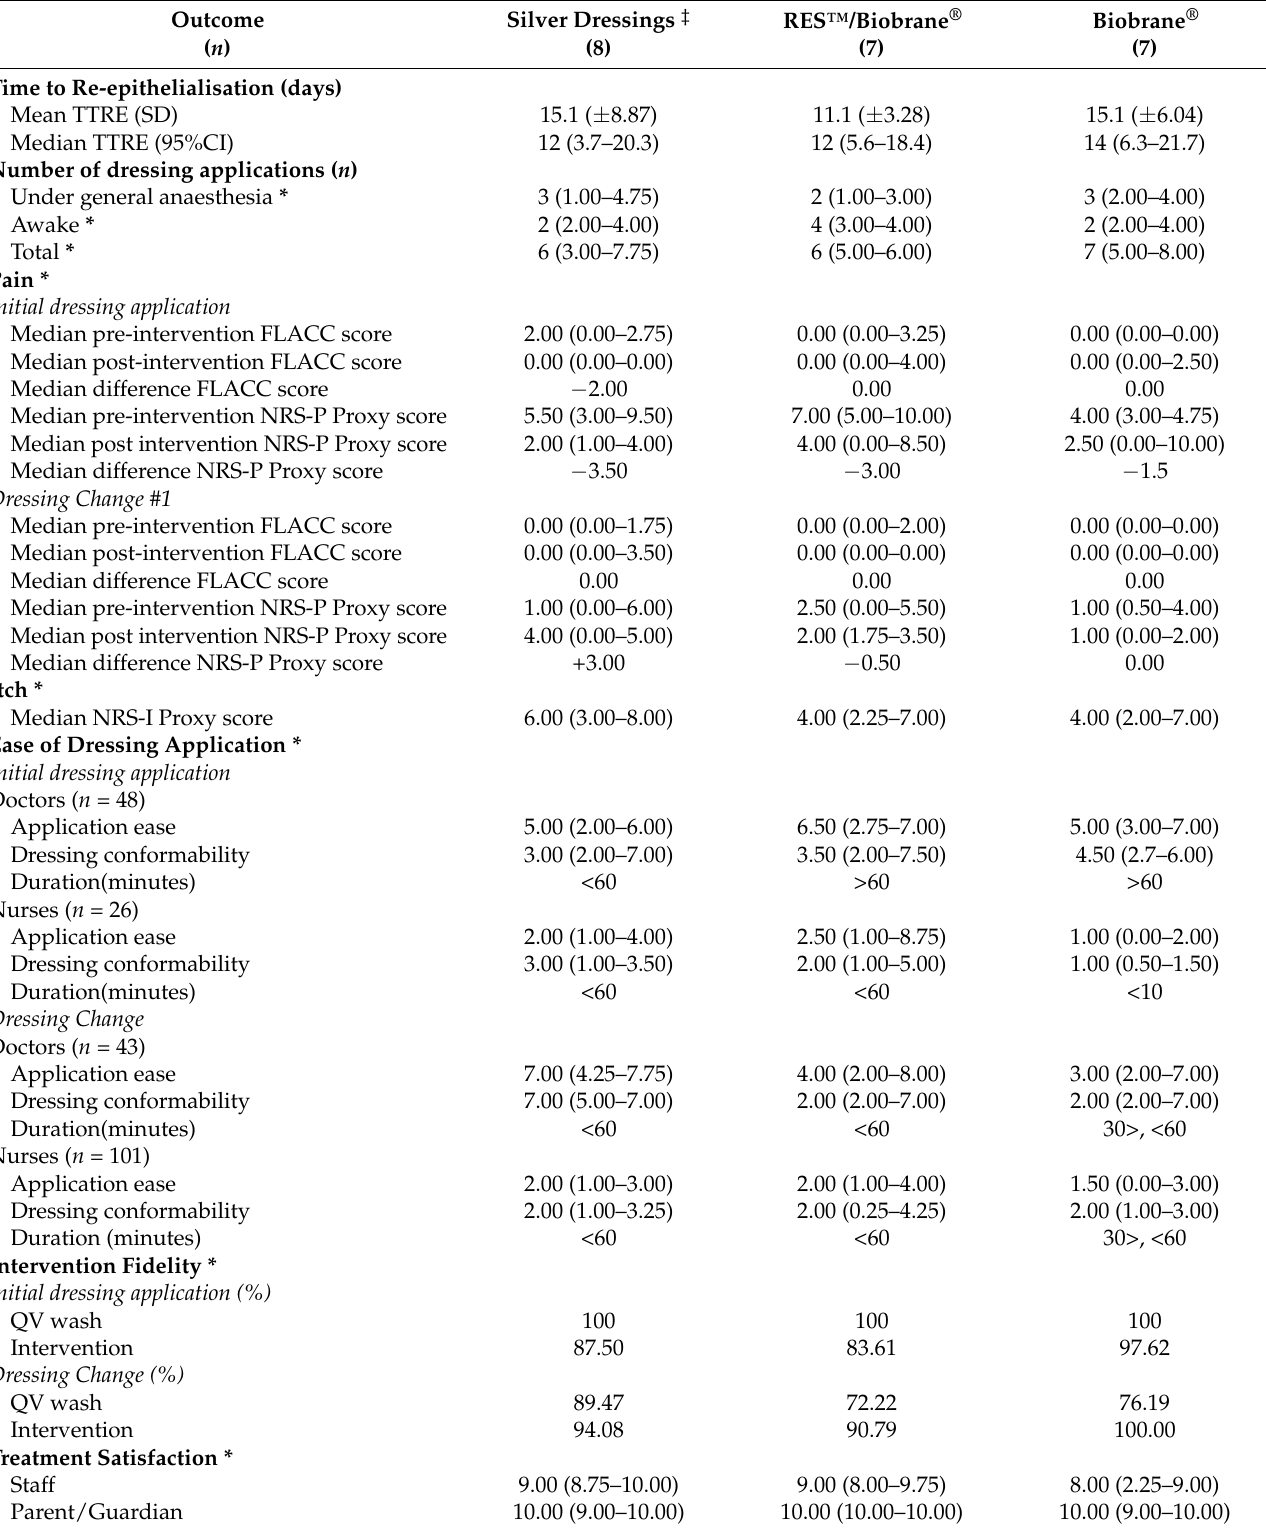
Table 3. Primary and secondary outcomes measured up to the primary endpoint of ≥ 95% burn wound